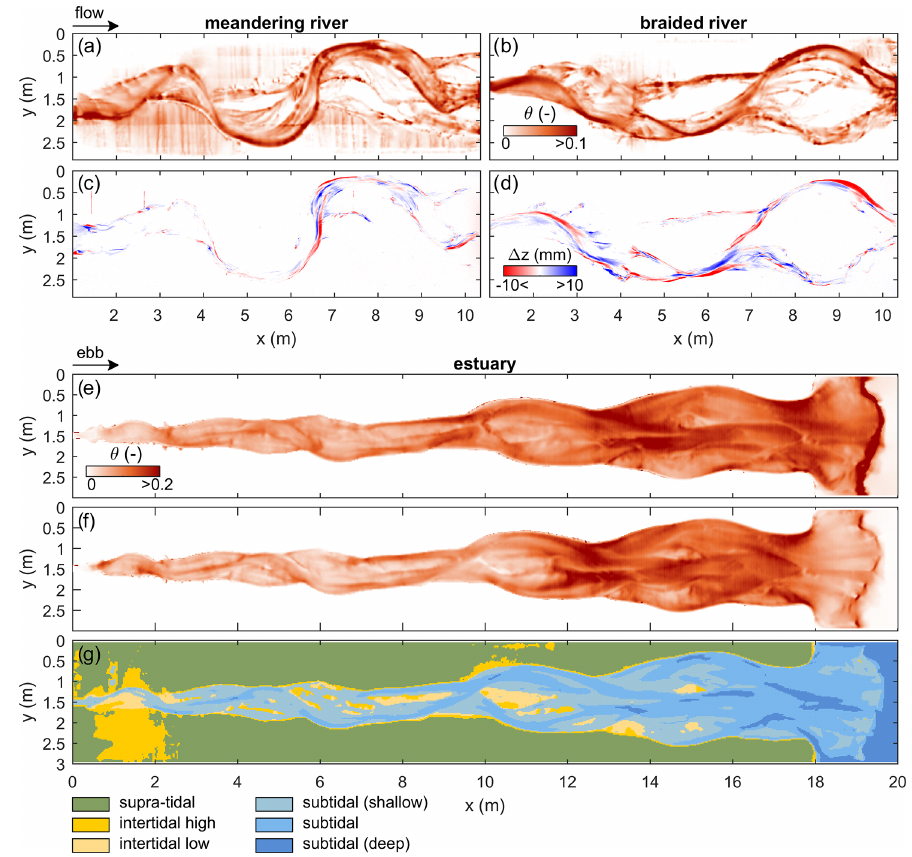
Figure 12. Complementary model data as maps of nondimensional bed shear stress (i.e. Shields numbers) and tidal zonation. Shields numbers for the (a) meandering and (b) braided rivers with the corresponding elevation-difference DEMs (c–d) with the next time step. (e) Maximum Shields numbers for the estuary in the ebb and (f) flood direction. (g) Classification of the estuary DEM in inundation classes based on modelled tidal flow. A similar classification is also applicable to unidirectional flow in rivers, as illustrated in Fig. S2a and